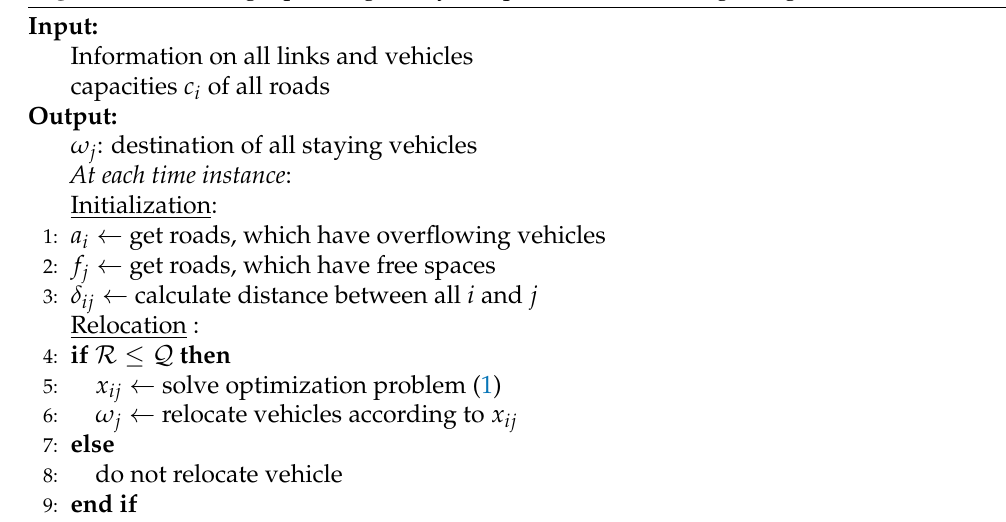
Algorithm 2 Parking Operating Policy 2: Optimal Flow Parking Assignment